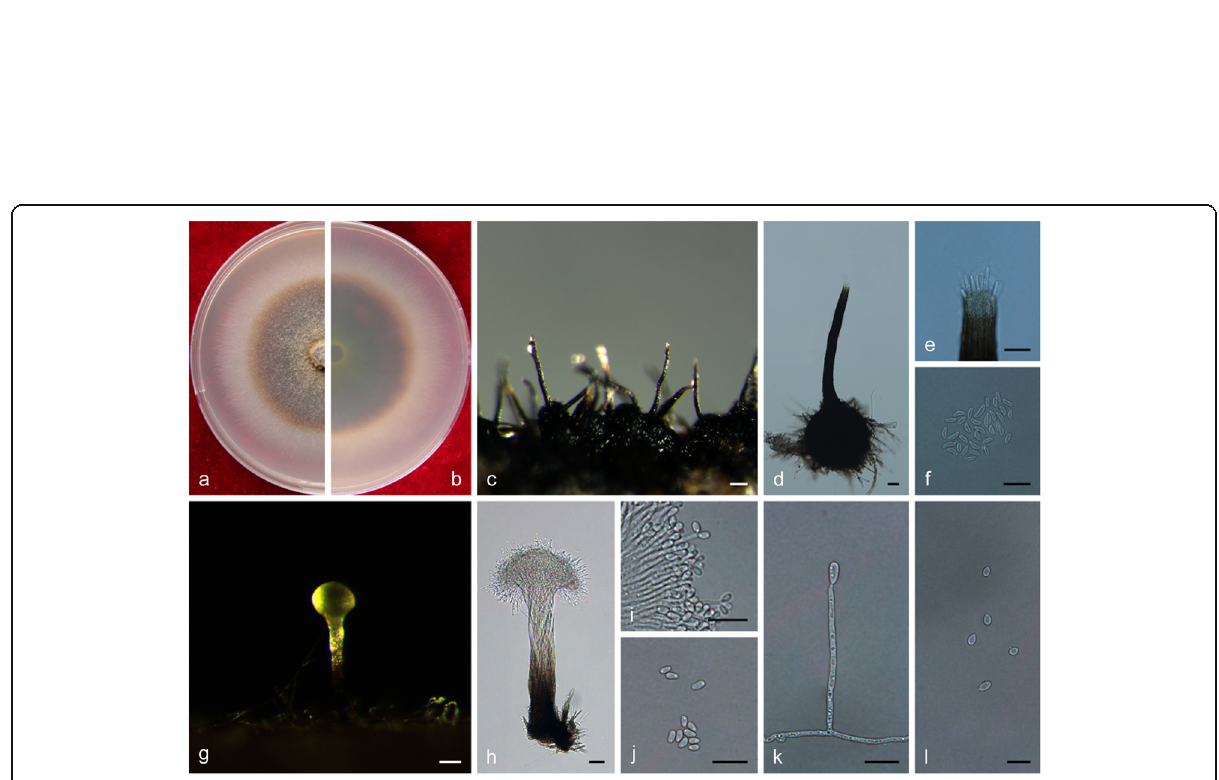
Fig. 12 Morphological characteristics of Ophiostoma genhense sp. nov. (CFCC 52675, Taxon 1). a – b. Ten-day-old cultures on 2% MEA; c – d. Perithecium. e. Ostiolar hyphae. f. Ascospores. g – h. Pesotum-like asexual morph; i – j. Conidiogenous cells of pesotum-like asexual morph and conidia; k – l. Hyalorhinocladiella-like asexual morph: conidiogenous cells and conidia. Scale bars: c = 50 μ m; d = 20 μ m; e – f = 10 μ m; g = 50 μ m; h = 20 μ m; i – l = 10 μ m